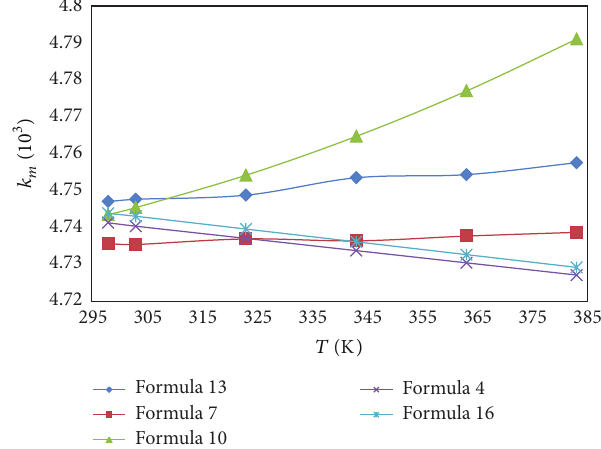
Figure 10: Molecular compressibility’s values calculated from five formulas for ethyl caprate at atmospheric